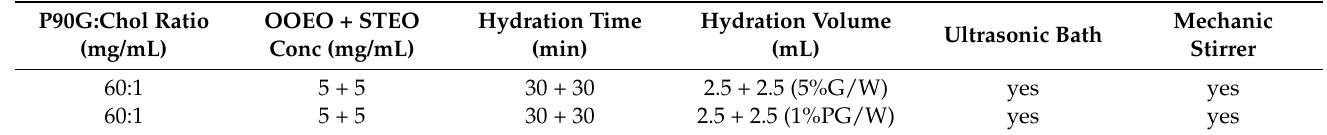
Table 10. Preparation of OOEO plus STEO-loaded